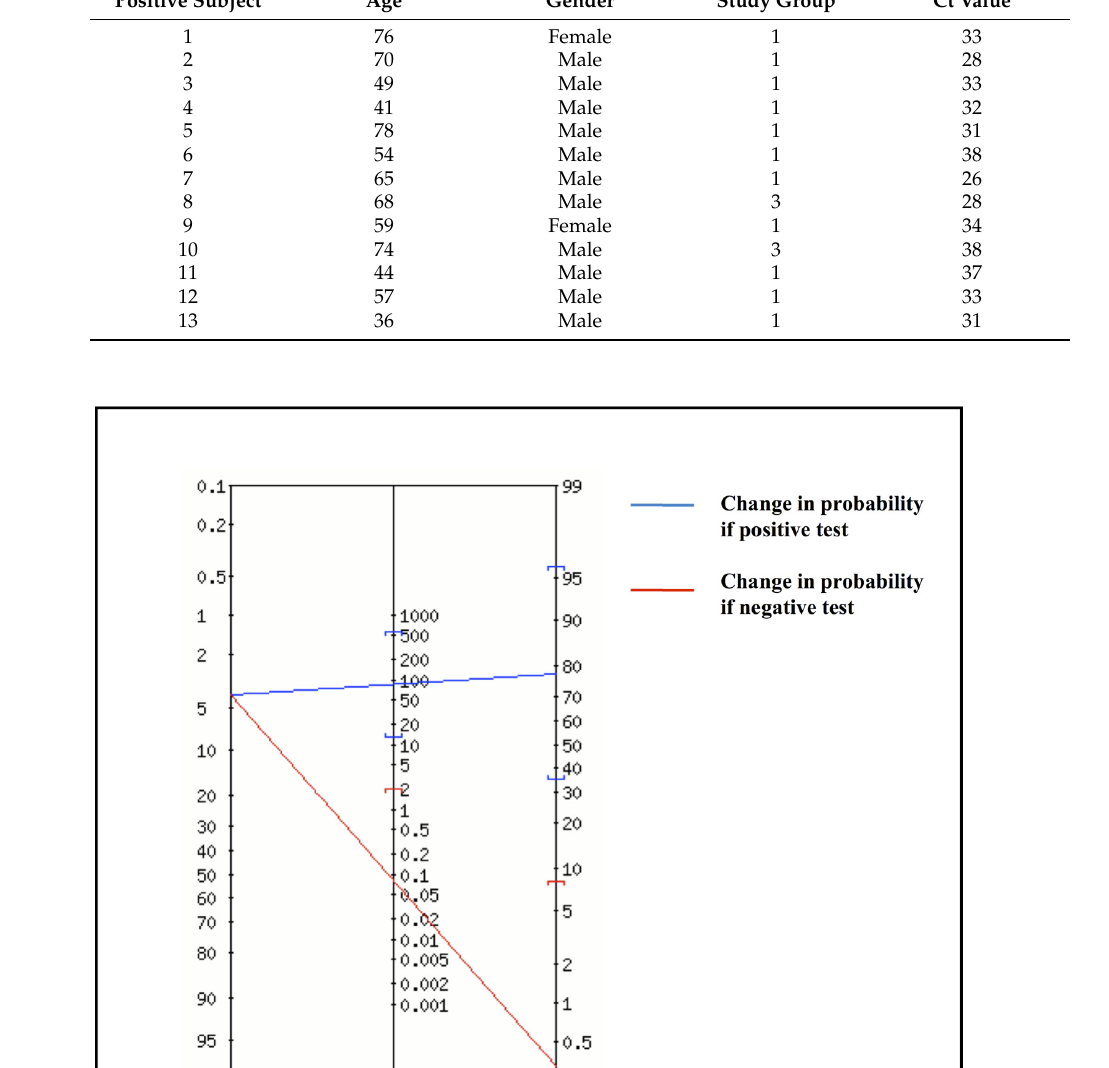
Table 4. Estimation of clinical performance of the Inflammacheck ® device compared to standard reverse transcriptase-polymerase chain reaction (RT-PCR) from nasopharyngeal swab specimens. Value